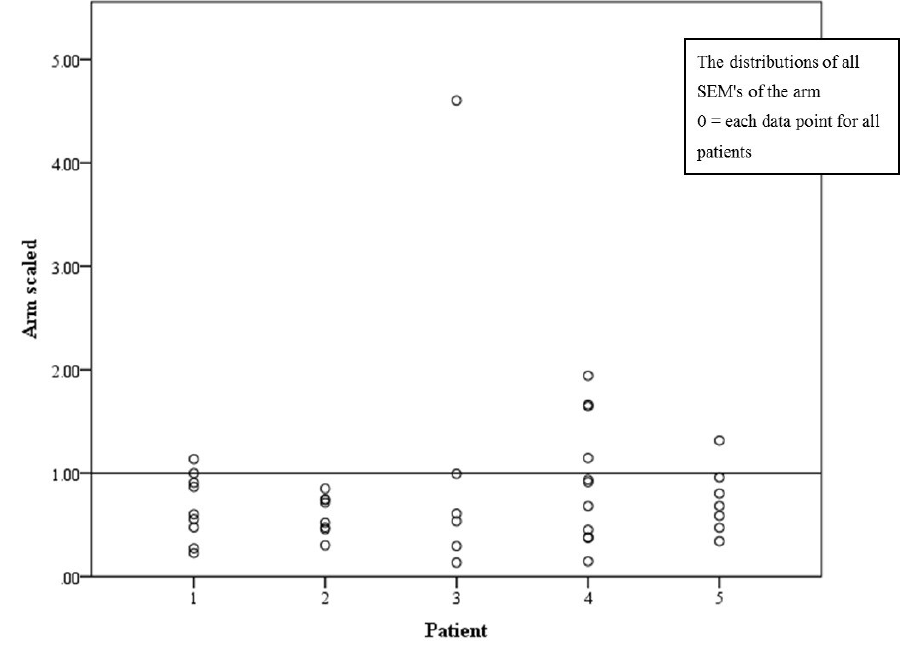
Figure 2. Scaled SEM presented in percentage, with the line at 1%